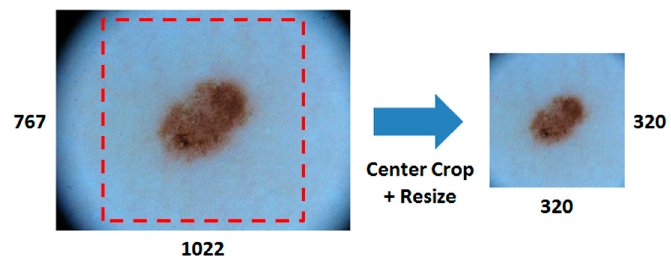
Figure 1. Pre-processing for skin lesion image. First crop the center area and then proportionally resize to a lower resolution. (The numbers of image size are measured by pixels). to a lower resolution. (The numbers of image size are measured by pixels).